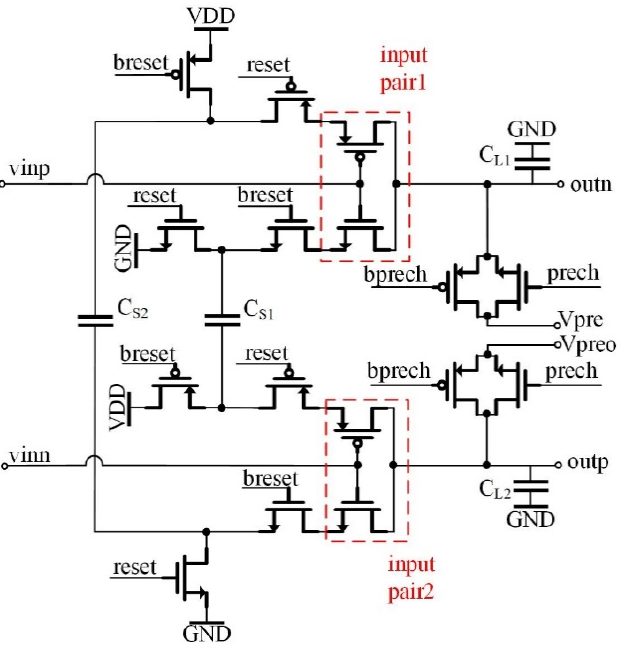
Figure 5. Schematic of the 1-bit quantizer.